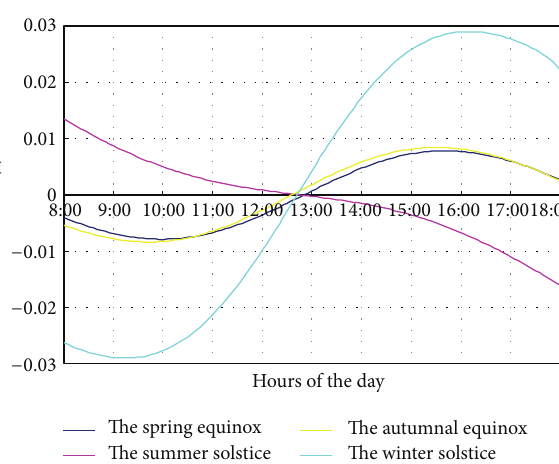
3.6. Comparison of All Factors. By calculating the tracking error of middle reflector (column 6) due to the various factors, the comparison results are shown in Table 1. From Table 1, the order of influence on tracking error is north-south orientation deviation, eccentric deviation, alti- tude angle deviation, longitude deviation, latitude deviation, center distance, and height deviation successively. Height deviation almost has no effect on the tracking precision of middle mirror. However, if the height deviation is 10 cm, the tracking error for mirror 1 is 0.2 ∘ in typical day, and if the center distance deviation is 10 cm, the error can reach 0.4 ∘